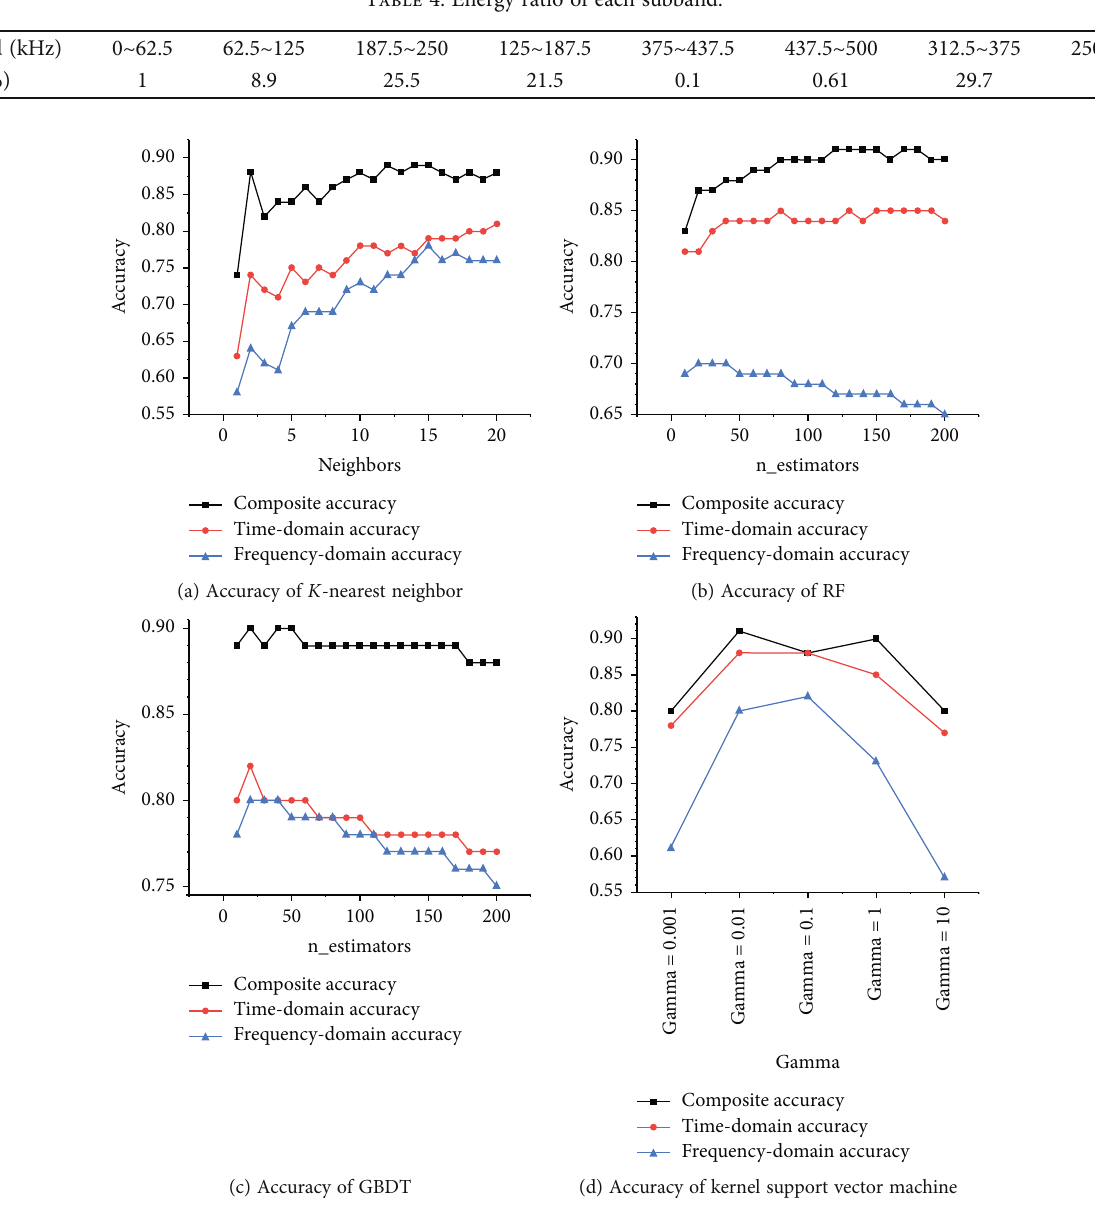
Table 4: Energy ratio of each subband.